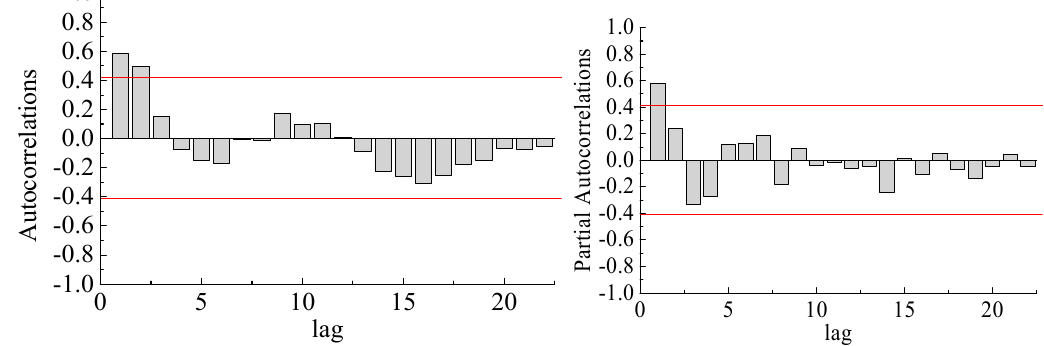
Figure 4. Autocorrelation coe ffi cient and partial autocorrelation coe ffi cient of pit gain time series after the first-order di ff